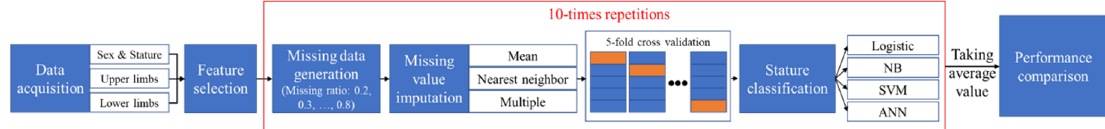
Figure 1. Schematic diagram of the research flow and analysis.